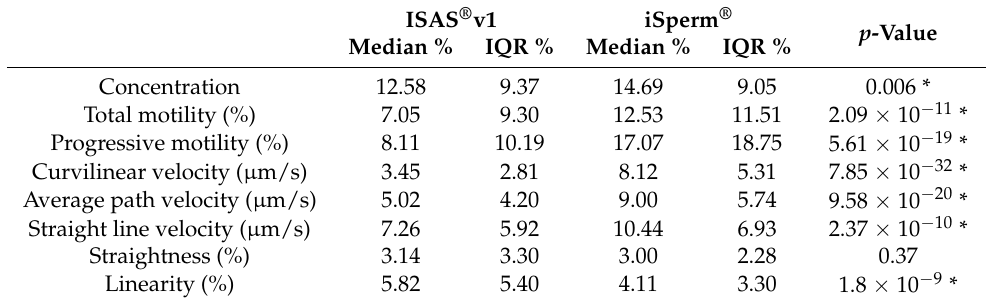
Table 1. Differences in intra-assay variability results (median and interquartile range–IQR) between ISAS ® v1 and iSperm ®